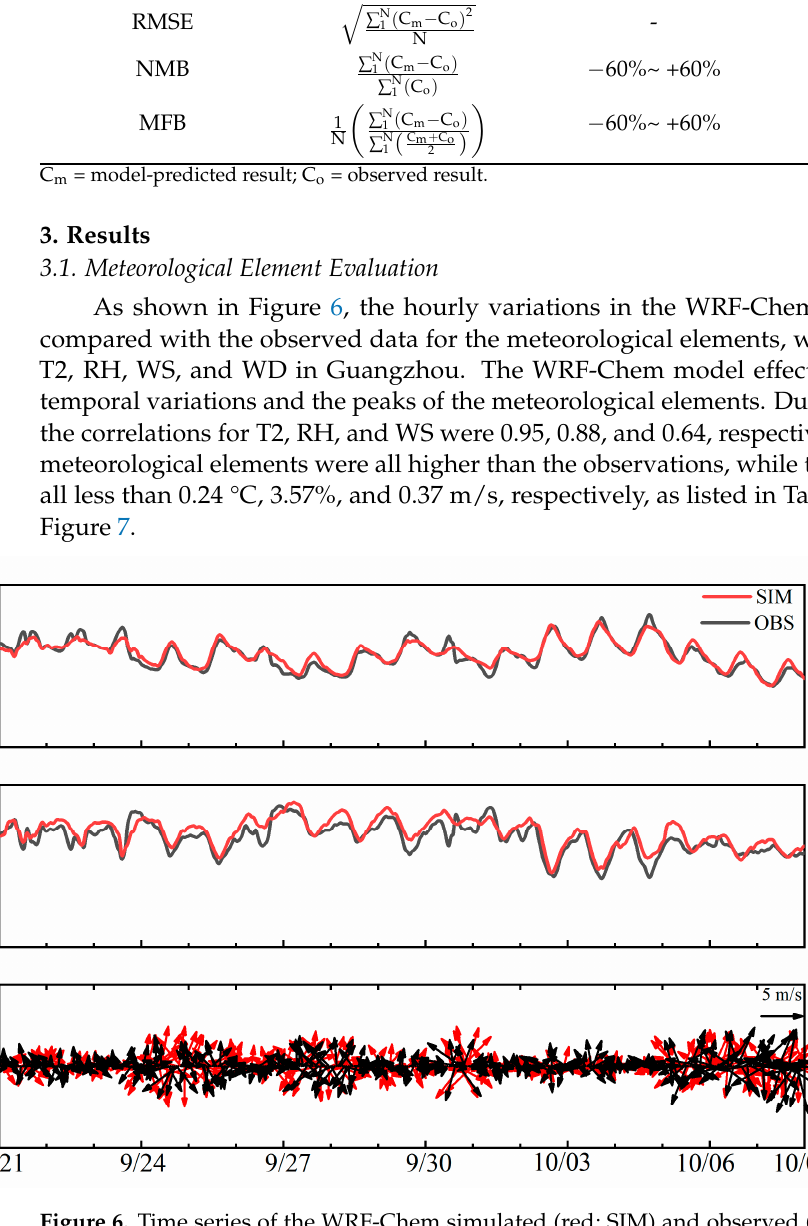
Figure 7. Scatter plots of the WRF-Chem simulated hourly data with the observed hourly data in Guangzhou. The black dashed lines were the 1:1 lines as the reference. ( a , b ) were the WRF-Chem model simulations of 2 m temperature and 2 m relative humidity, respectively. Table 5. Evaluations of the meteorological simulations in Guangzhou. Variables